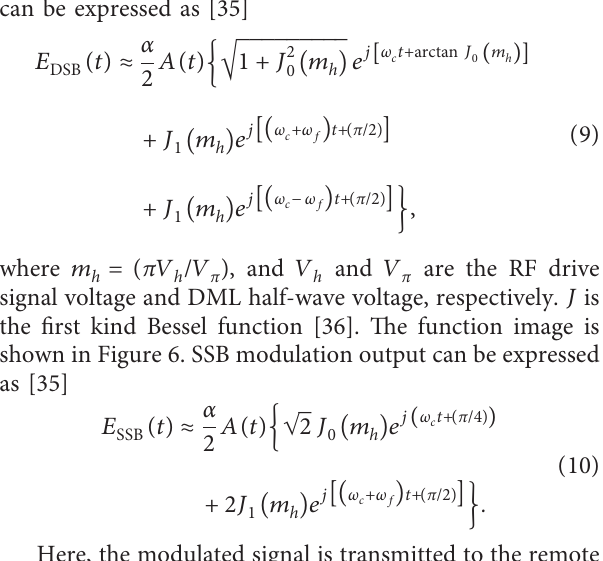
Figure 6: Graph of the first kind Bessel